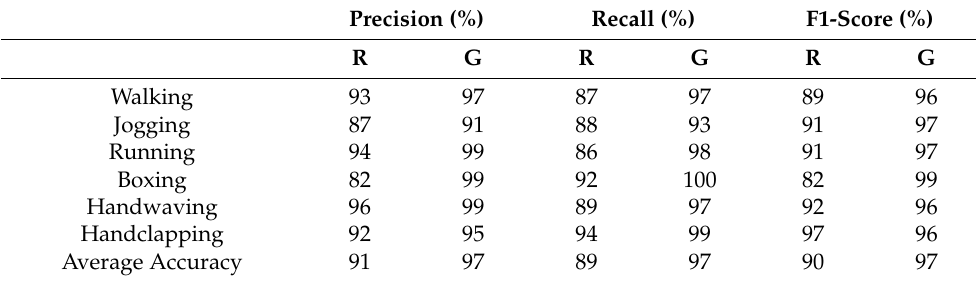
Table 5. RGB base (R) and Growth (G) Performance Analysis on KTH dataset.